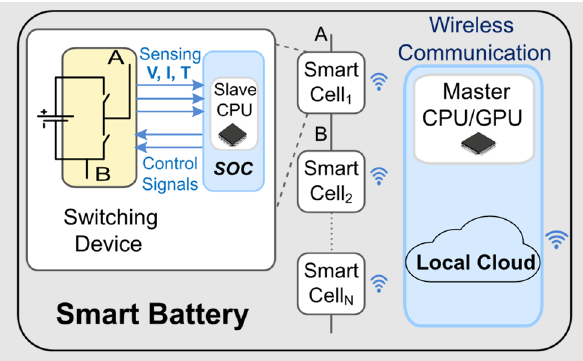
Figure 2. High-level architecture showing Smart Battery with slave controllers and a master controller.